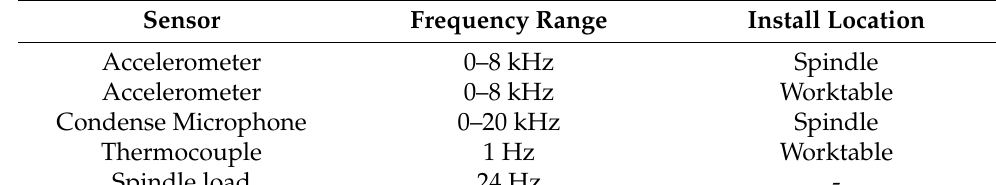
Table 2. Sensor Information.